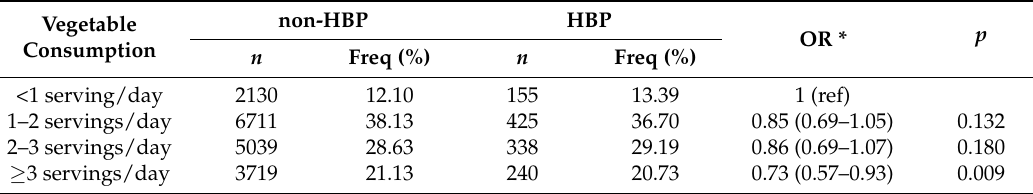
Table 3. Association between vegetable consumption and high blood pressure in 13–17-year-old adolescents.